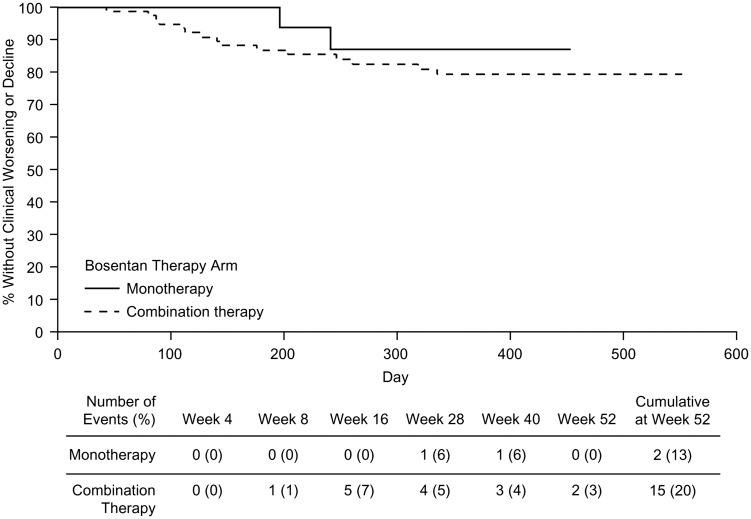
Kaplan–Meier plot of time to clinical worsening and/or clinical decline.